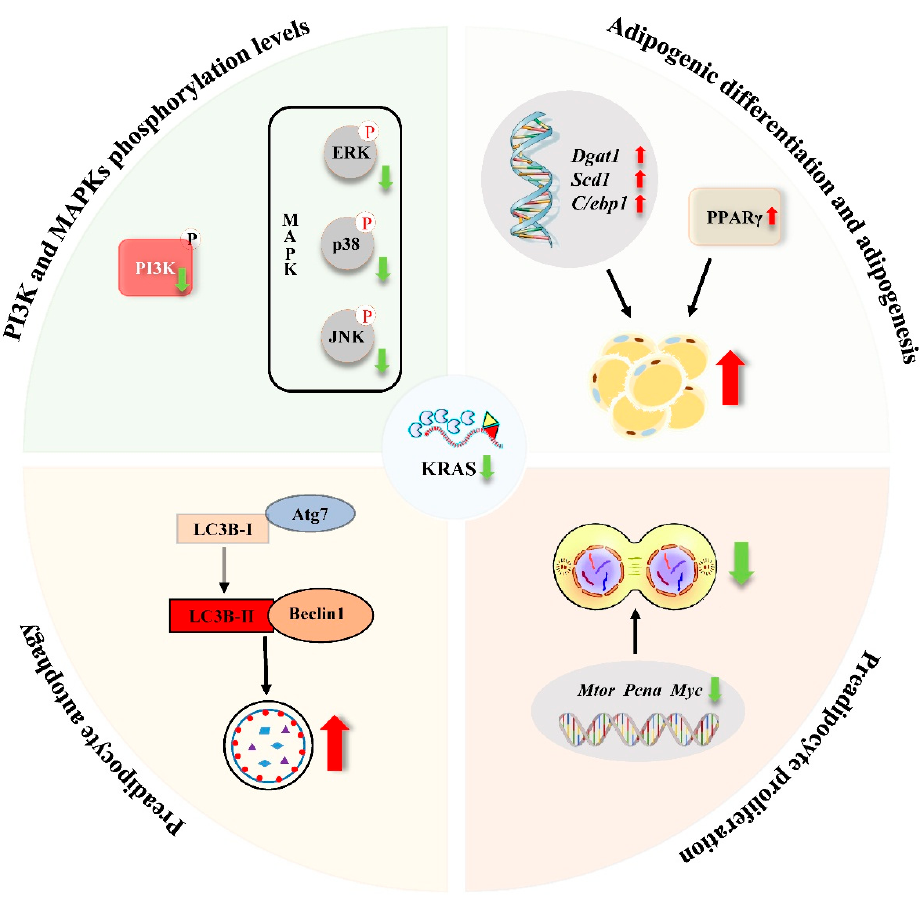
Figure 7. Schematic diagram of the effects of KRAS inhibition in 3T3-L1 and C2C12 cells. After KRAS inhibition, cell proliferation ability ( Mtor , Pcna , and Myc ) and phosphorylation levels of PI3K and MAPKs (ERK, JNK, and p38) were downregulated, while autophagy levels (LC3B puncta, Atg7, and Beclin 1 ) and adipogenic differentiation and adipogenesis (TG, Dgat1 , Scd1 , C/ebp1, and PPAR γ ) were up-regulated in 3T3-L1 and C2C12 cells.